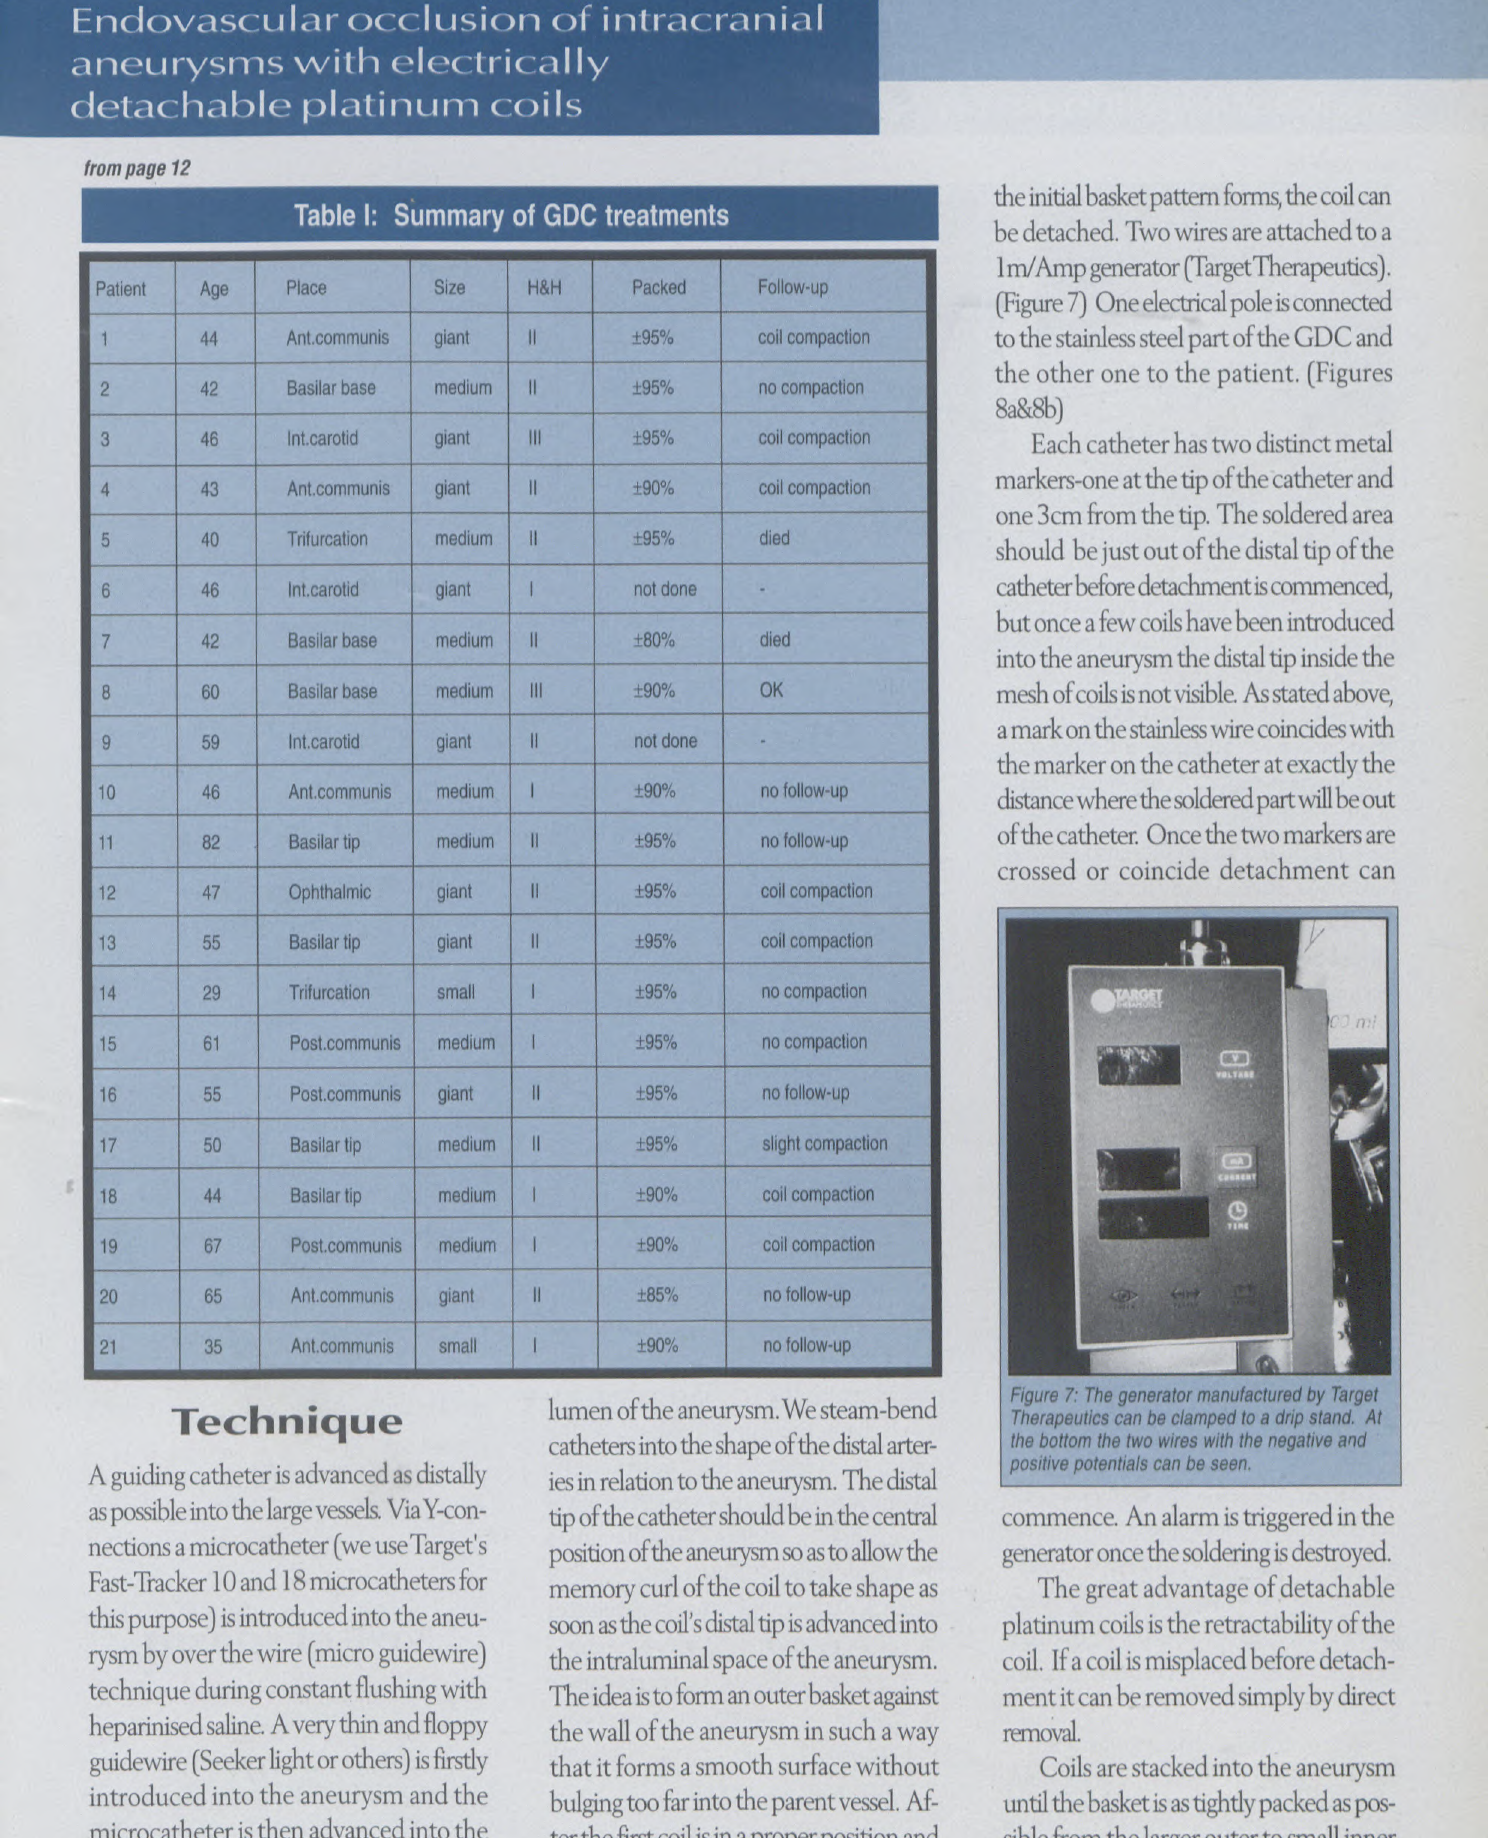
Figure 7: The generator manufactured by Target Therapeut/cs can be clamped to a drip stand. At the bottom the two wires with the negative and posilive potentials can be